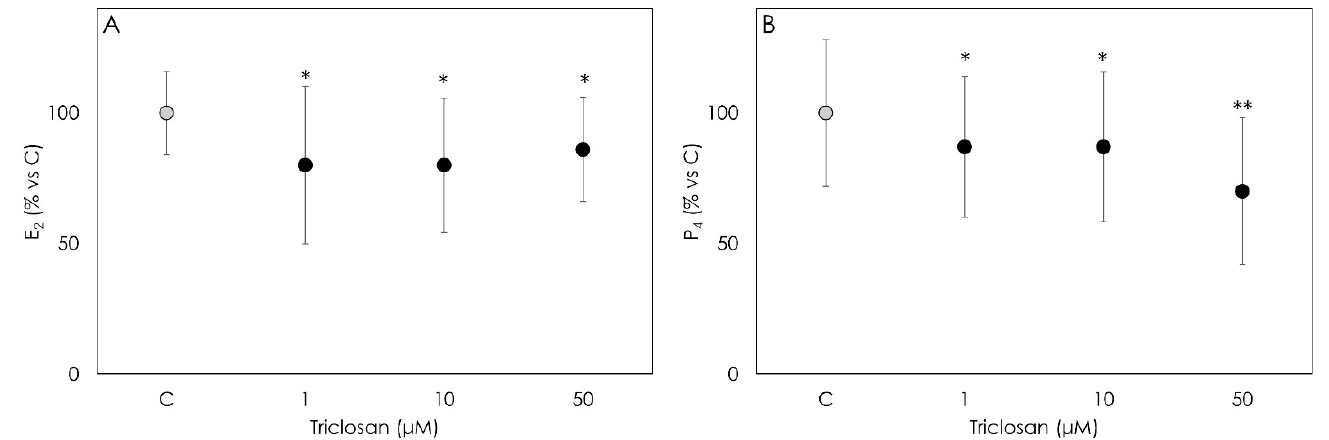
Figure 2. Results of the production of 17 β estradiol (E2) ( A ) and progesterone ( B ) by porcine granulosa cells treated for 48 h with Triclosan (1, 10 or 50 μ M) detected by ELISA assay. Data are expressed as % vs. control and represent the mean ± SD of six replicates/treatment repeated in five different experiments (n = 30). Asterisks on points indicate that data show significant differences ( p < 0.001).